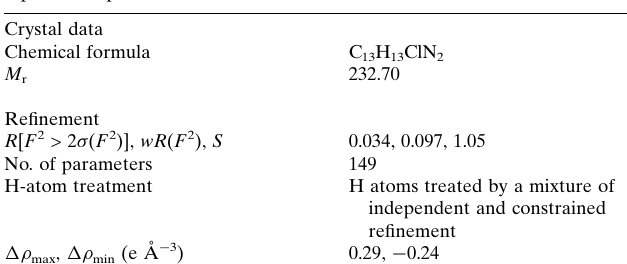
H (cid:2) (cid:2) (cid:2) Cl interactions (Table 1), resulting in an R 3 which forms a supramolecular sheet extending along the b axis, as shown in Fig. 2 a .’ Revised experimental details are given in Table 2.